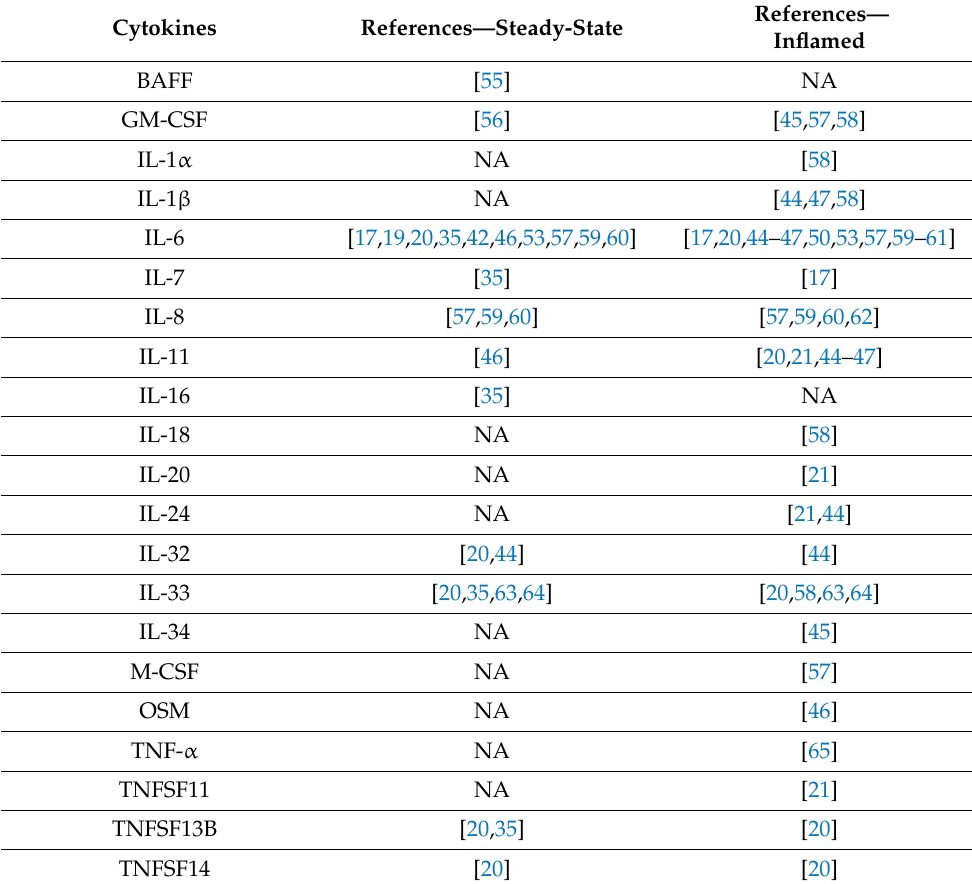
Table 3. List of cytokines expressed by IMCs under steady-state and inflammatory conditions.